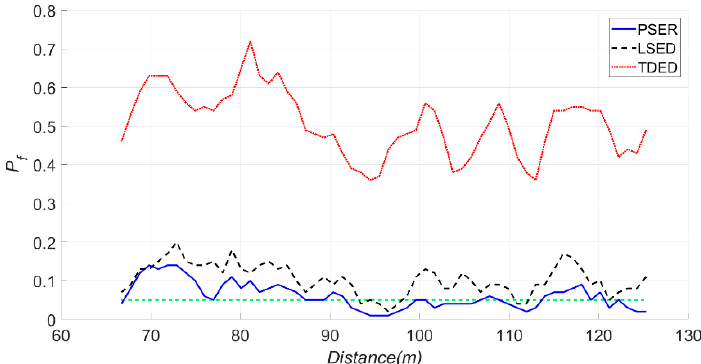
Figure 25. False alarm probabilities of the PSER, LSED, and TDED, where the sub-band was 66–105 Hz, N was 1024, and P f was 0.05.